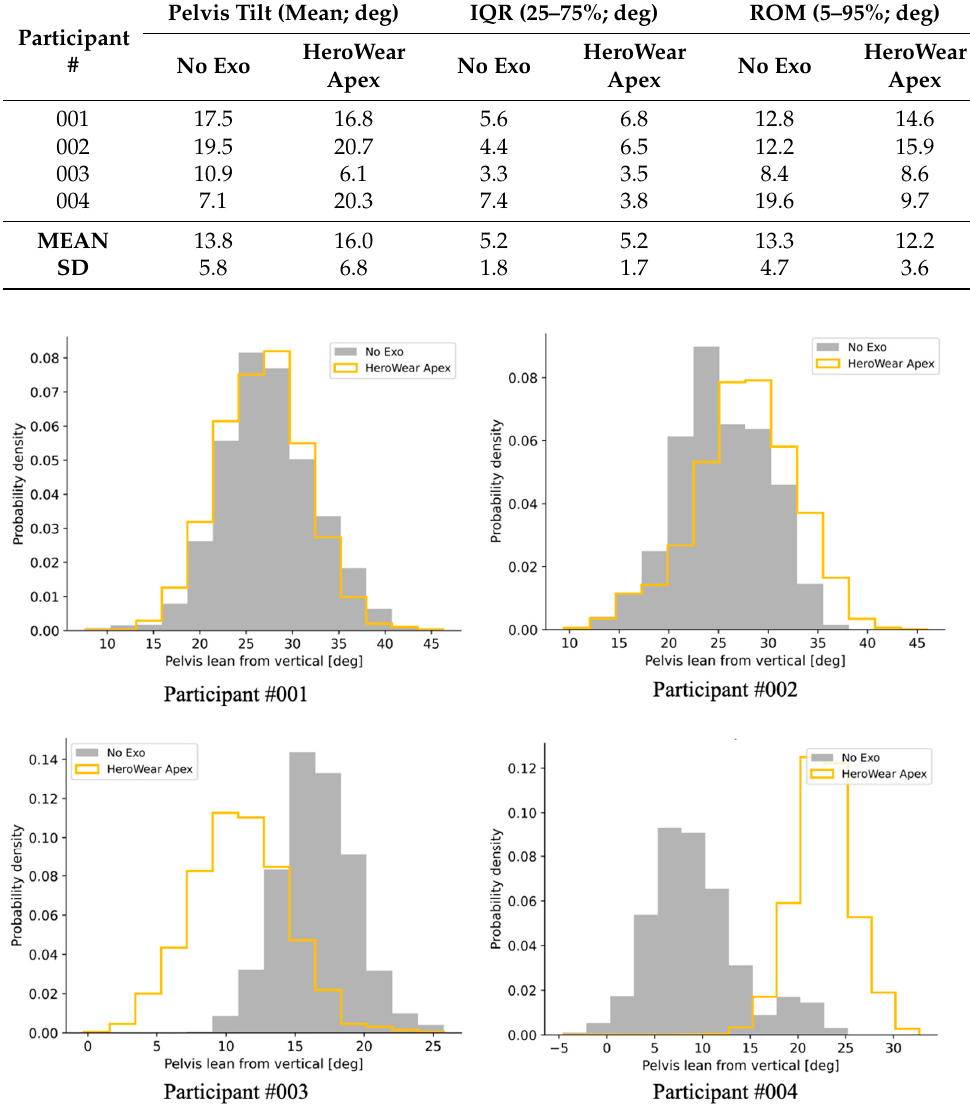
Figure 7. Histograms of pelvis lean from vertical for pushing the loaded gondola at level ground. Table 5. Pelvis tilt (deg) for pushing the unloaded gondola at level ground.